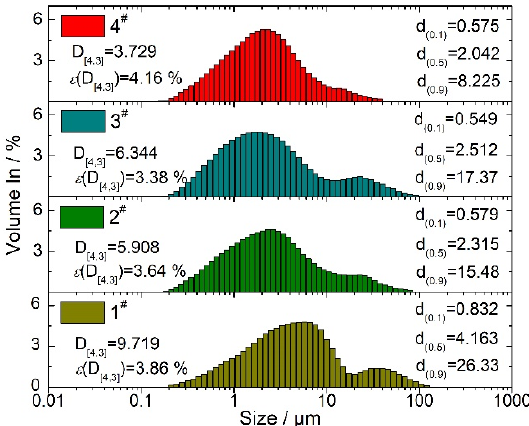
Figure 11. Particle Size Distributions of CCPs. Table 6. Burning Rates of Propellants and Corresponding Combustion Efficiencies of Al. Propellant No.